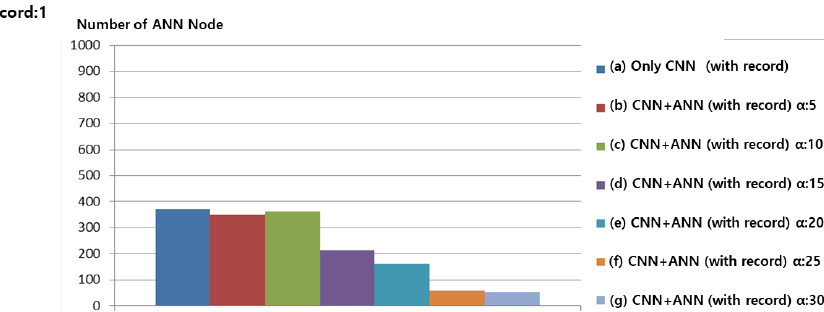
Figure 13. Number of ANN Nodes when Record was one.